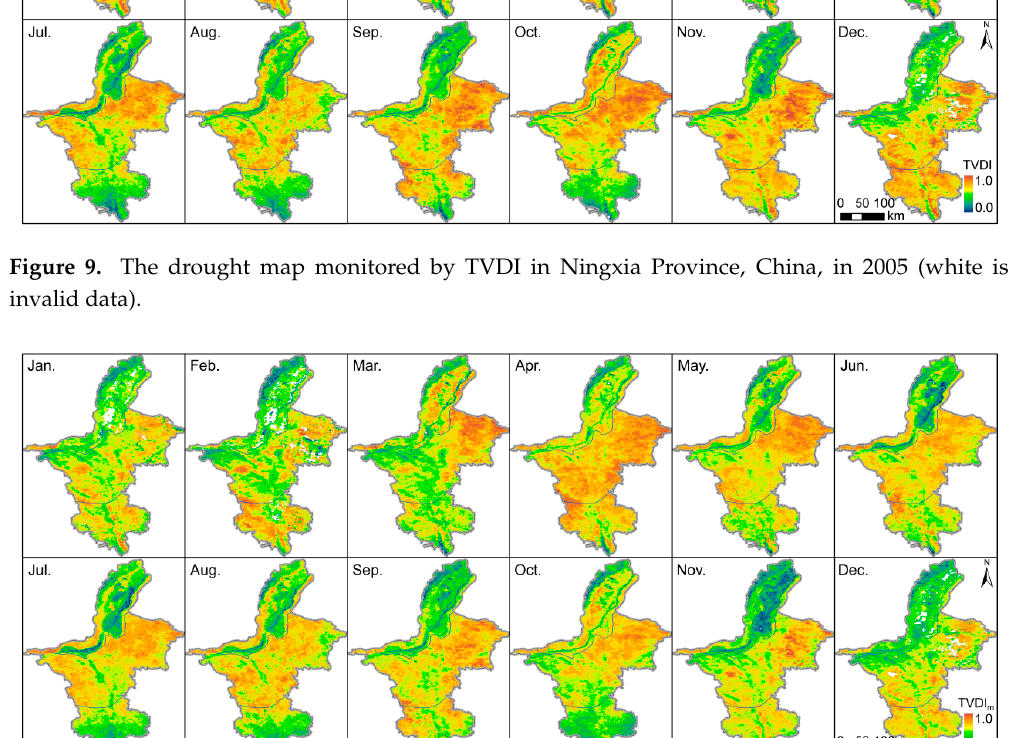
Figure 10. The drought map monitored by TVDI m in Ningxia Province, China, in 2005 (white is invalid data).